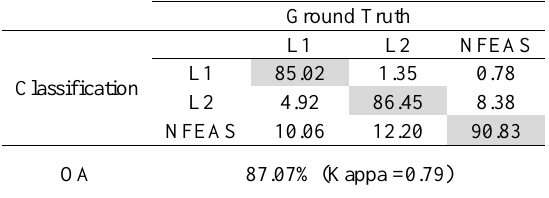
Table 6. Confusion matrix for change detection classification’s evaluation. Levels 3 and 4 were merged as they both represent NFEAS.